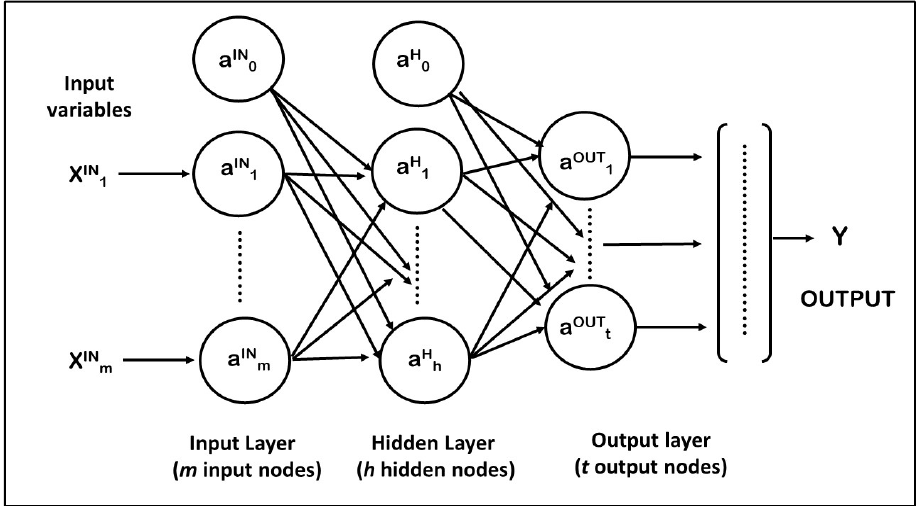
Figure 2. A Three-layer Multi-Layer Perceptron (MLP), with m input nodes (IN), h hidden nodes (H), and t output nodes (OUT). The term a 0(J) is the bias, for J = IN, H